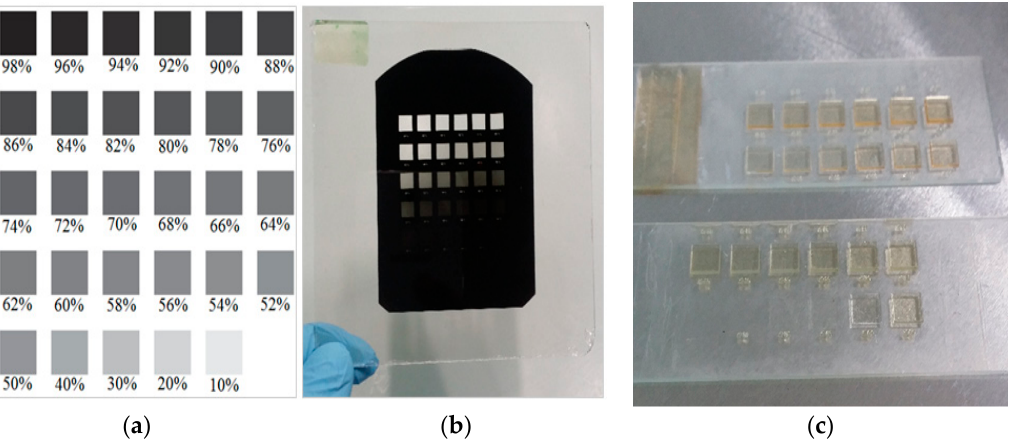
Figure 1. ( a )software mask, ( b ) emulsion mask and ( c ) SU8 mould of various grayscale